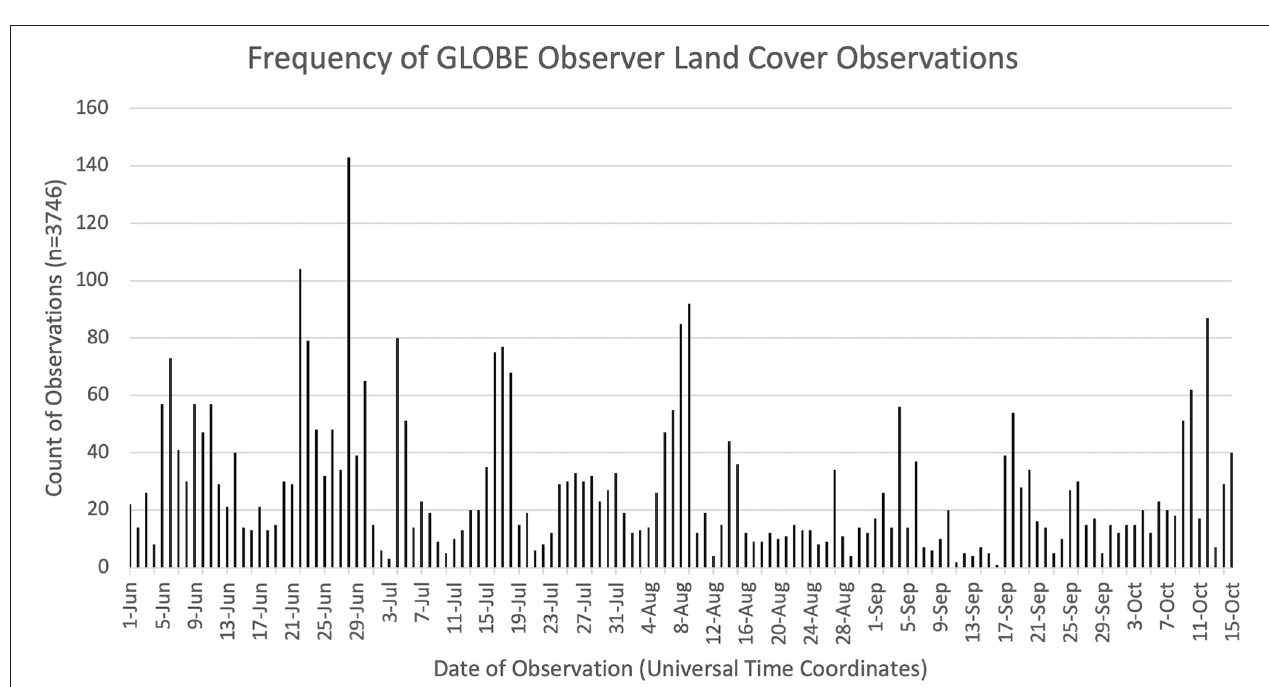
all observations with classification labels submitted during this data challenge, the most common LCLU type mapped was herbaceous land (grasses and forbs, 387 sites) followed